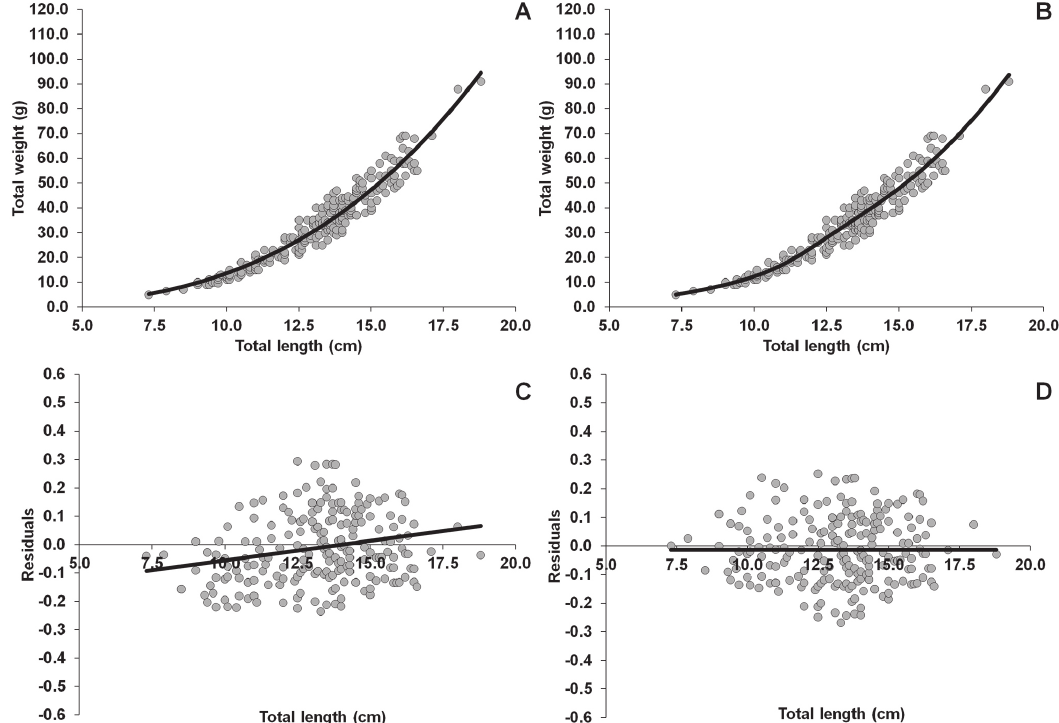
Fig. 2. Length/weight relationship of male Auchenipterichthys longimanus. A and C represent Huxley regular length/weight relationship and its distribution of proportional residuals. B and D represent polyphasic length/weight relationship its and distribution of proportional residuals.